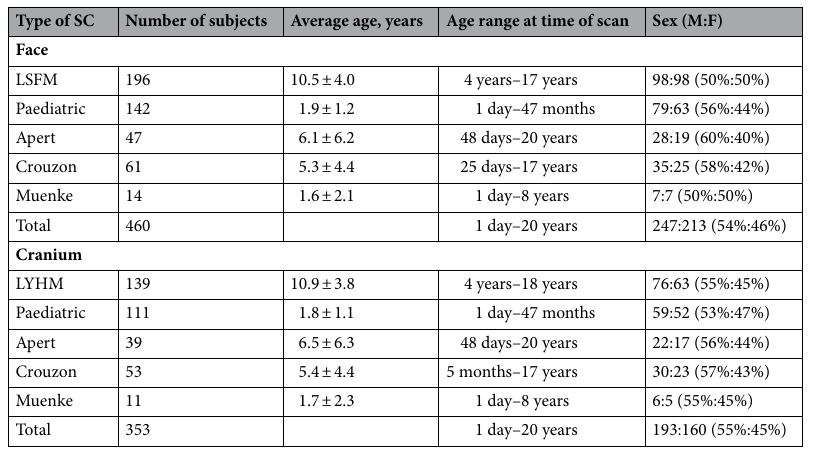
Table 1. Overview of the face and cranium dataset of the included Syndromic Craniosynostosis and normal samples. All syndromic and infant samples were acquired via CT-scan. The LSFM and LYHM databases were obtained using 3dMDphotometric stereo capture device set-ups 10,11